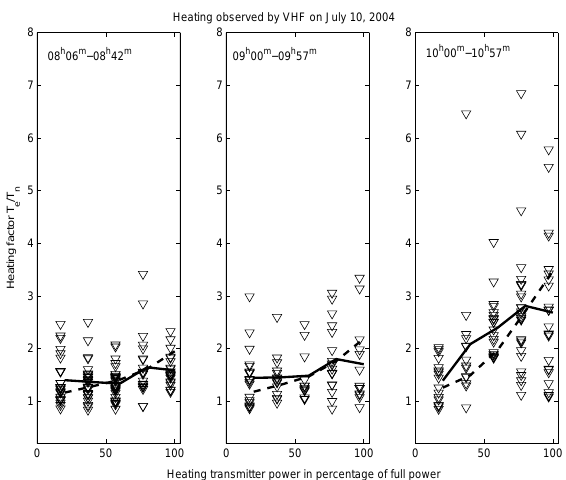
Fig. 5. All calculated heating factors T e, hot /T i , for three hours of observations, plotted against the transmitter power in percent of full power. The full line shows the line through the average of the ob- served heating factors for the different heater transmitter intensities, while the dotted lines are the average heating, over the height inter- val 81–89km, resulting from model calculations shown in Fig. 6, see